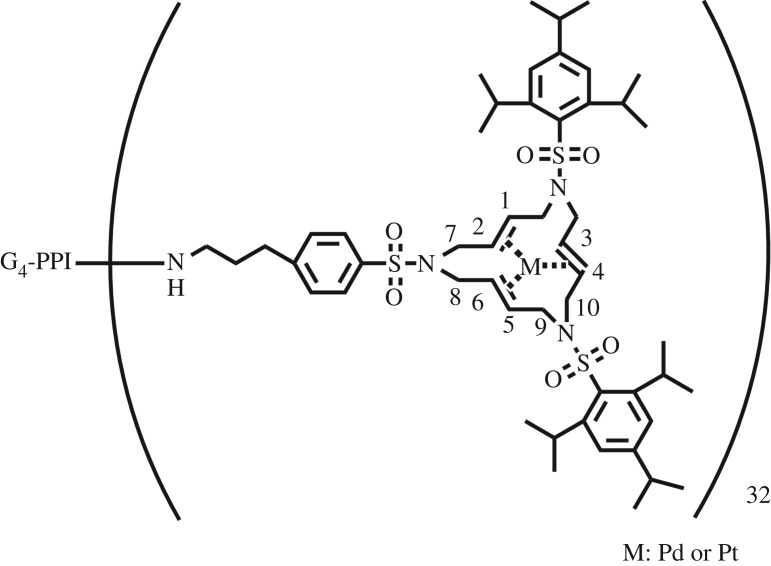
The chemical structure of GnM-(Ptx/Pd10−x) (n = 2, 3, 4, 5).